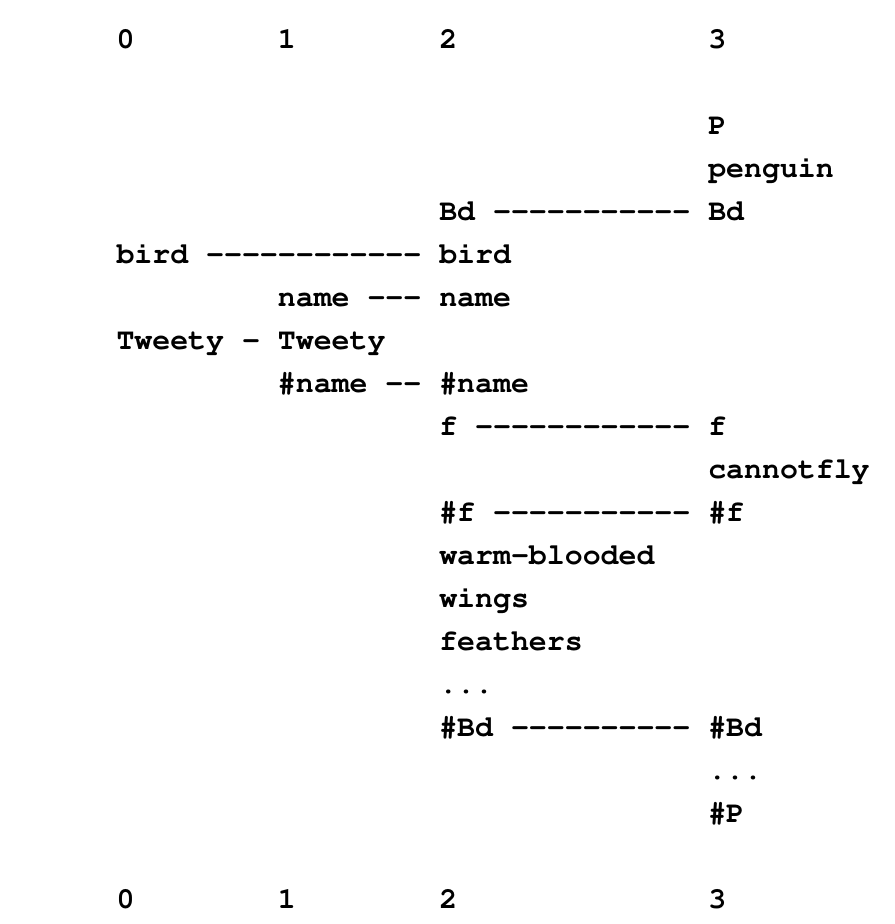
Figure 19. The last of the three best multiple alignments formed by the SP model with “ bird Tweety ” in New and patterns in Old, as described in the text. The relative probability of this multiple alignment is